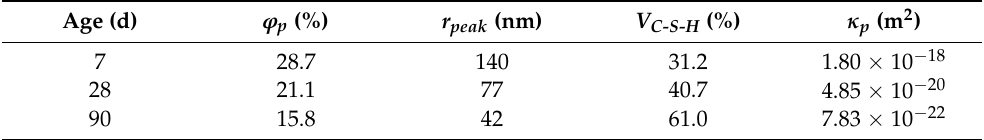
Table 3. Calculated permeability of ECC paste.